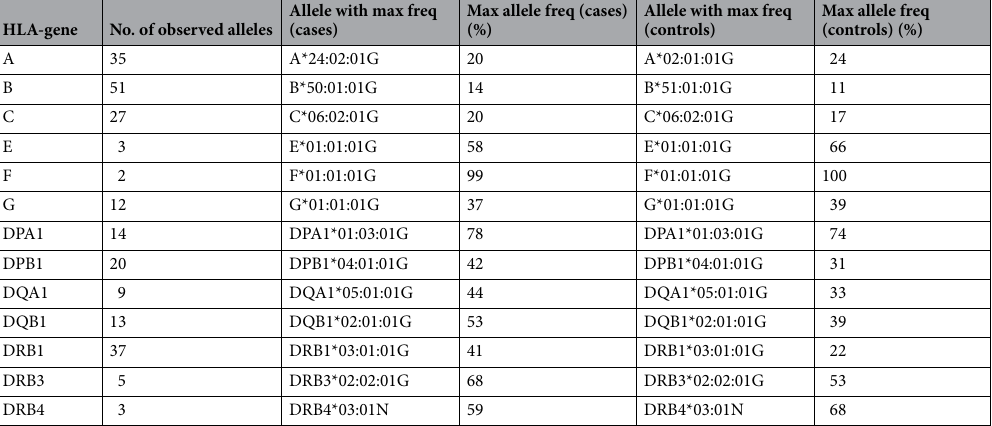
Table 3. Distribution of observed alleles across HLA- genes. Alleles were observed for each gene and the allele(s) with maximum frequency in cases and controls for each